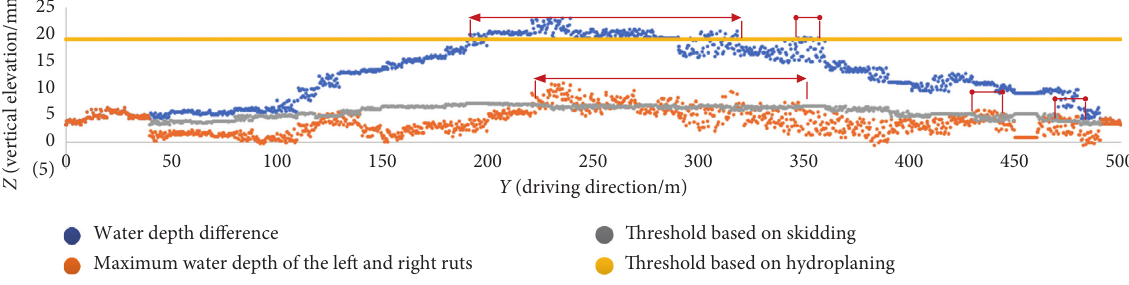
Figure 12: Safety assessment of the water-filled rut (100km/h).